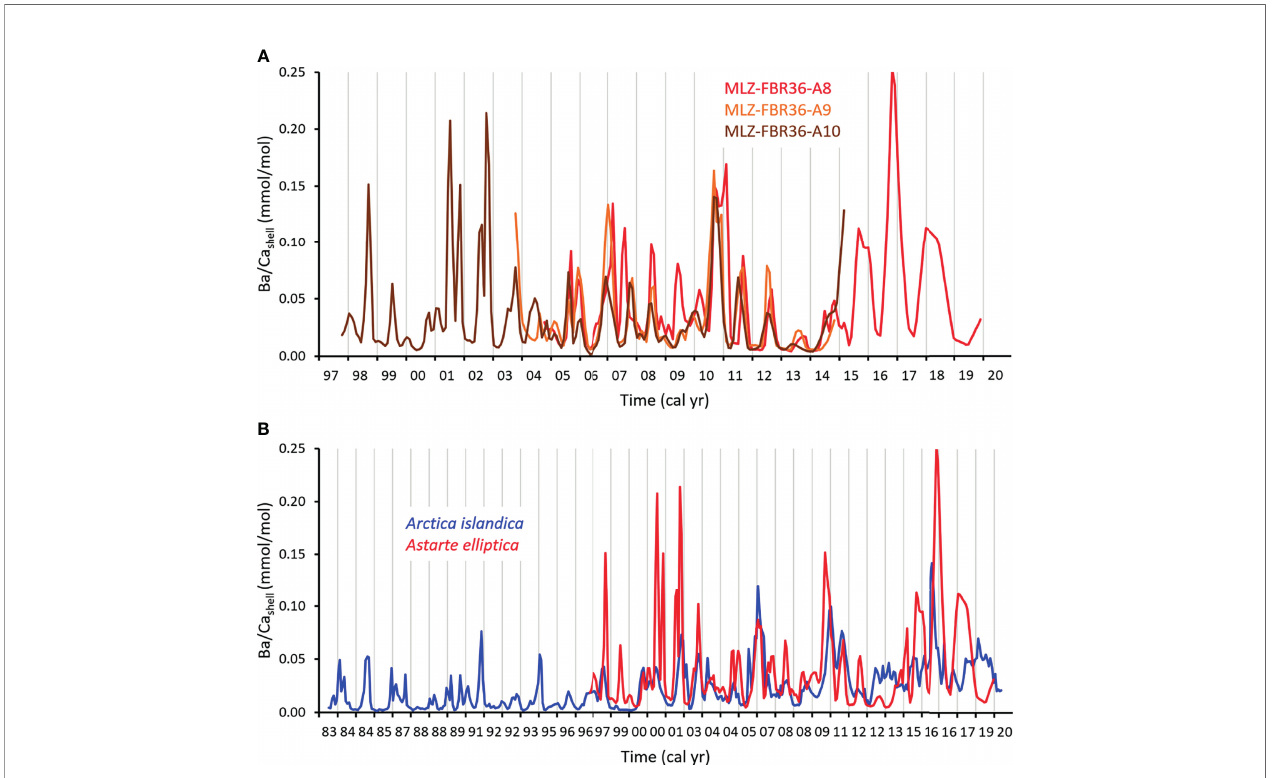
FIGURE 3 | Monthly Ba/Ca shell chronologies validate the proper temporal alignment of the shell data. Chronologies show a strong running similarity between specimens of the same species (example from A. elliptica ) (A) as well as across species boundaries (B) . Chronologies in (B) represent the average of fi ve specimens of A. islandica and three specimens of A. elliptica ,